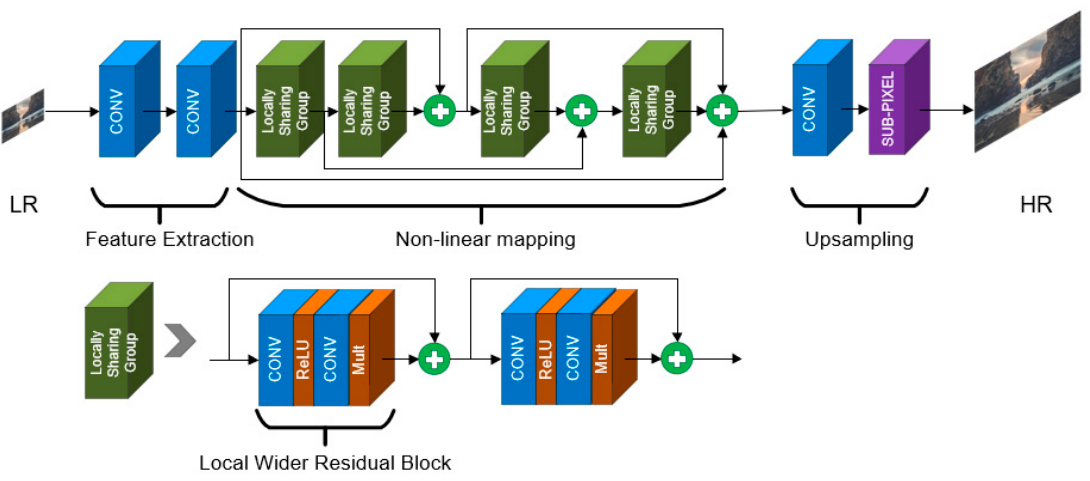
Figure 8. CRN network structure.